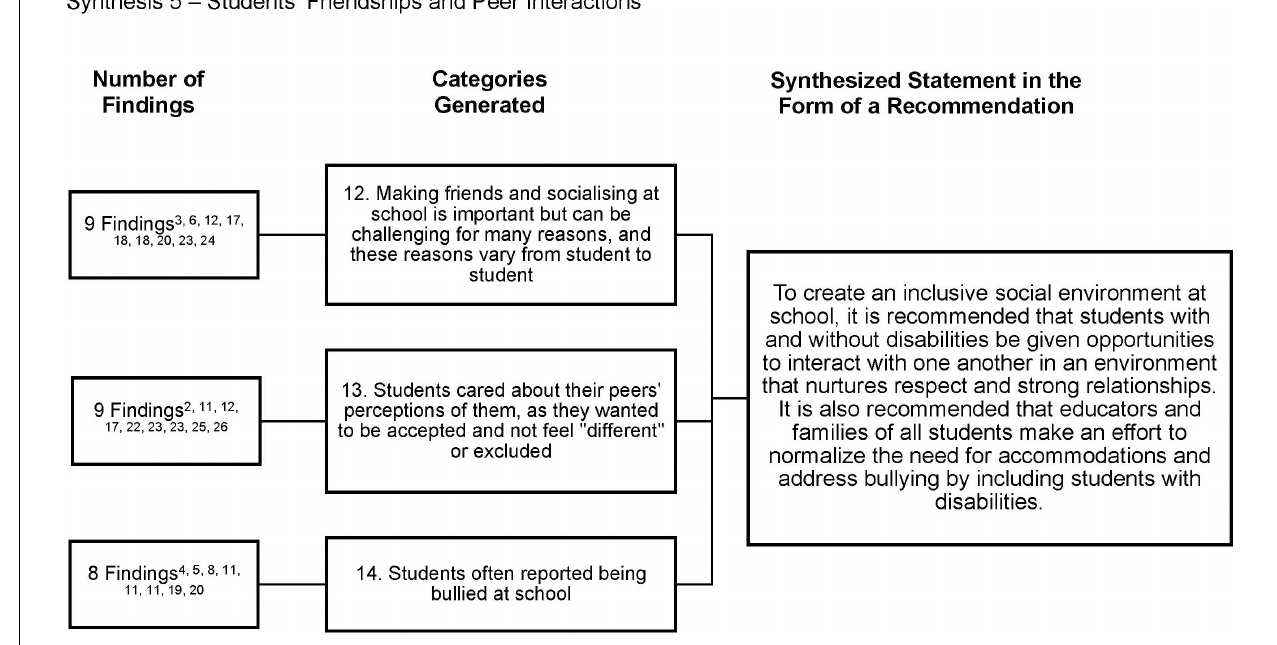
FIGURE 6 | Synthesis 5 – students’ friendships and peer interactions. The superscript numbers under “Number of Findings” corresponds to the study numbers in Table 3 .